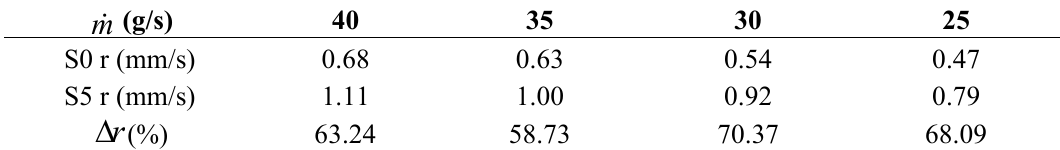
Table 7. The contrast of fuel regression rate r in different